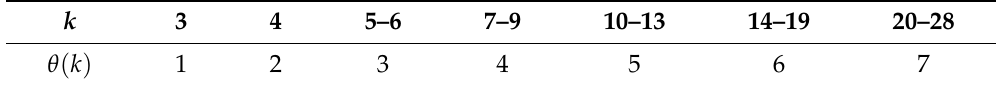
Table 4. The minimal number of carry-save adder (CSA) stages θ ( k ) required by the k -operand